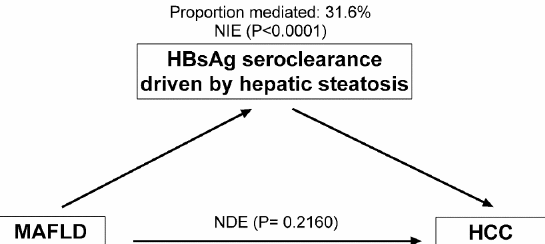
Figure 3. Directed acyclic graph of a structural model of mediation of the association between MAFLD and hepatocellular carcinoma (HCC) by HBsAg seroclearance driven by hepatic steatosis. The mediation analysis was performed using a bootstrapping procedure with 5000 resamples. NDE: natural direct effect; NIE: natural indirect effect. The adjusted cumulative incidences and HRs of HCC dramatically increased with an increasing number of metabolic abnormalities. Furthermore, a similarly high risk of HCC was observed in those with ≥3 risk abnormalities for subjects with and without hepatic steatosis, and for subjects with and without HBsAg seroclearance (Figure 4).